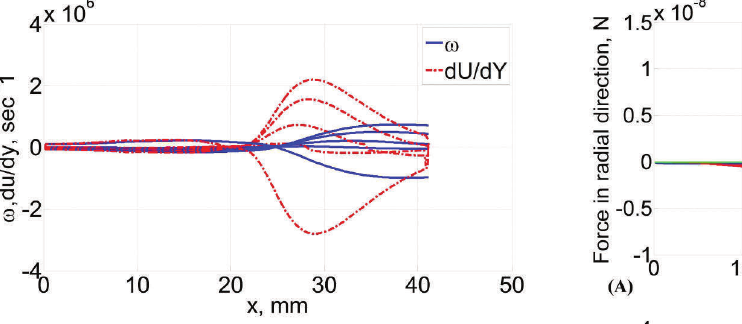
Figure 10. Angular velocity of the particles, ! , and gas velocity gradient, du , vs. distance along the nozzle axis. dy applied are shown in Figure 11 in solid red, and dashed green, respectively. The trajectories of the particles are